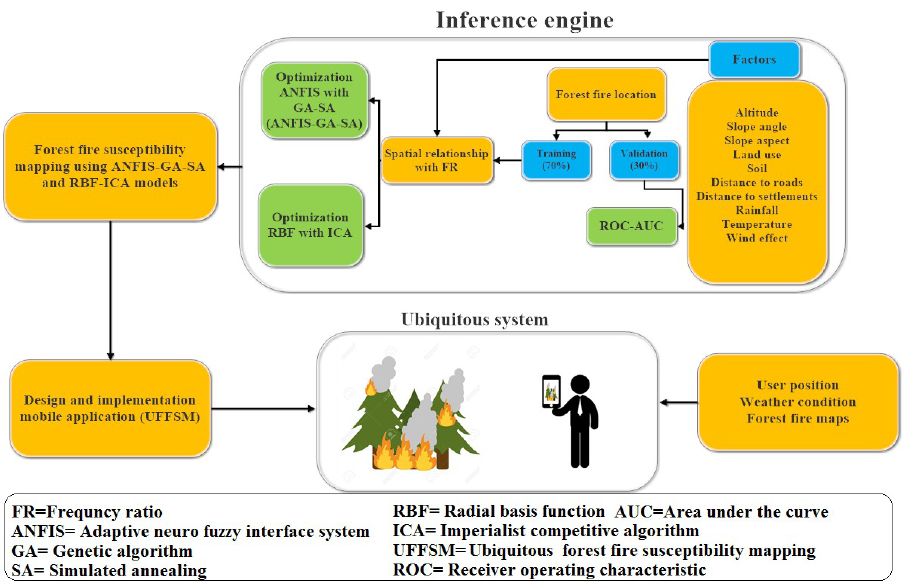
Figure 2. Methodology flowchart.